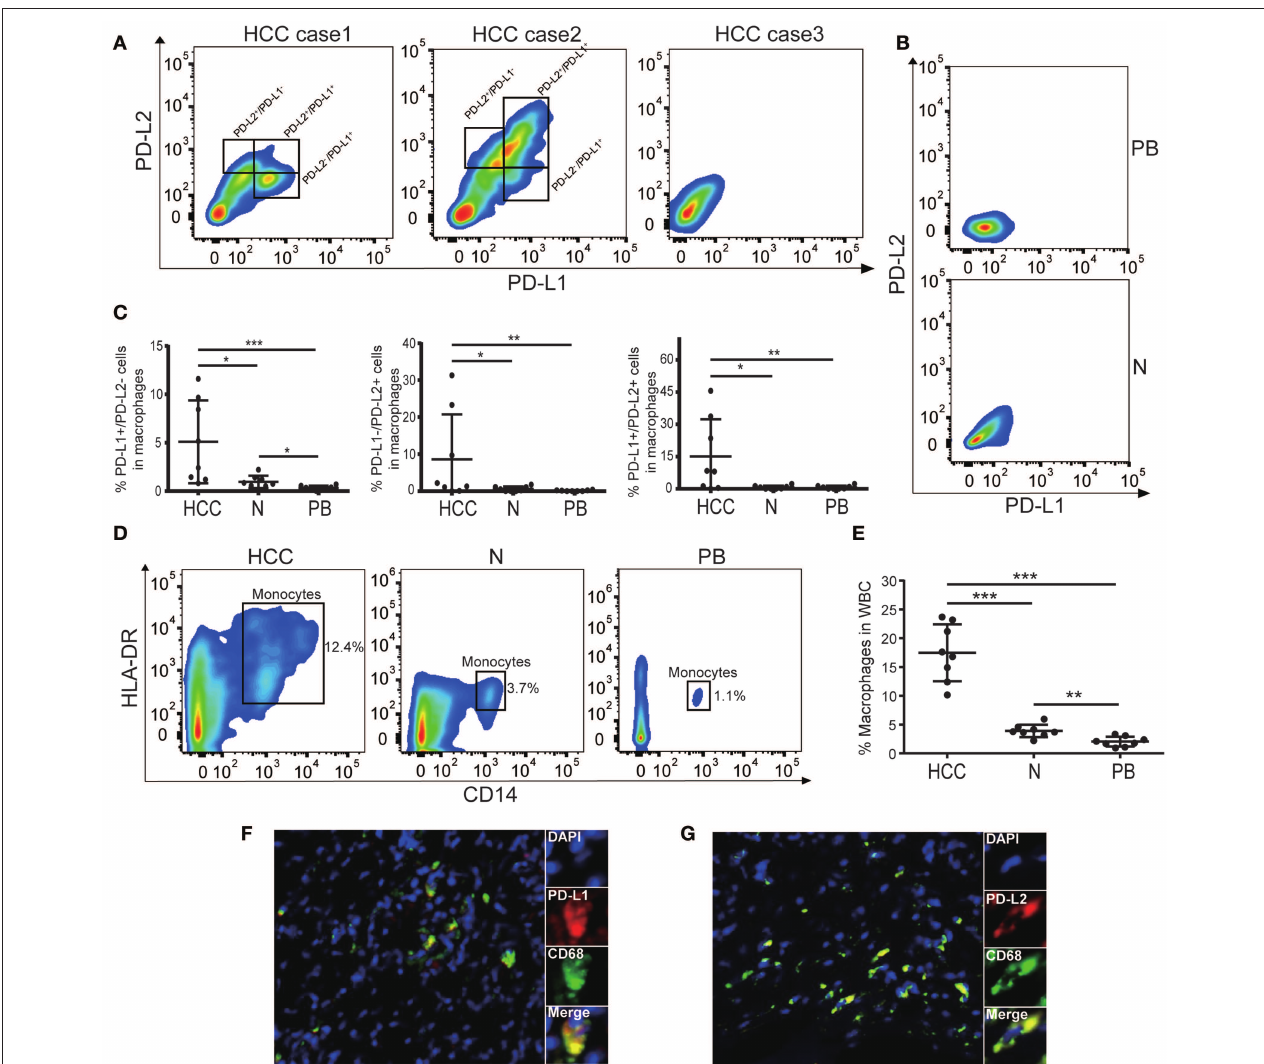
FIGURE 2 | The expression of PD-Ls in macrophages from HCC tissues. (A) Representative flow cytometry analysis showing that both PD-L1 and PD-L2 can be expressed by HLA-DR + CD14 + macrophages. (B) Representative flow cytometry analysis demonstrating the absence of PD-Ls in HLA-DR + CD14 + macrophages in adjacent normal tissues and peripheral blood. PB, peripheral blood; N, adjacent normal tissues. (C) Aggregate data showing higher proportions of PD-L1 + , PD-L2 + , PD-L1 + /PD-L2 + macrophages in HCC tissues compared with adjacent normal tissue and peripheral blood ( n = 8). PB, peripheral blood; N, adjacent normal tissue; * P < 0.05; ** P < 0.01; *** P < 0.001. (D) Flow cytometry plots demonstrating higher percentage of macrophages in HCC tissues compared with adjacent normal tissue and peripheral blood ( n = 8). PB, peripheral blood; N, adjacent normal tissue. (E) Aggregate data showing a higher proportion of macrophages in HCC tissues compared with adjacent normal tissue and peripheral blood ( n = 8). PB, peripheral blood; N, adjacent normal tissue; ** P < 0.01; *** P < 0.001. (F,G) Immunofluorescence staining showing PD-L1 + (F) and PD-L2 + (G) in